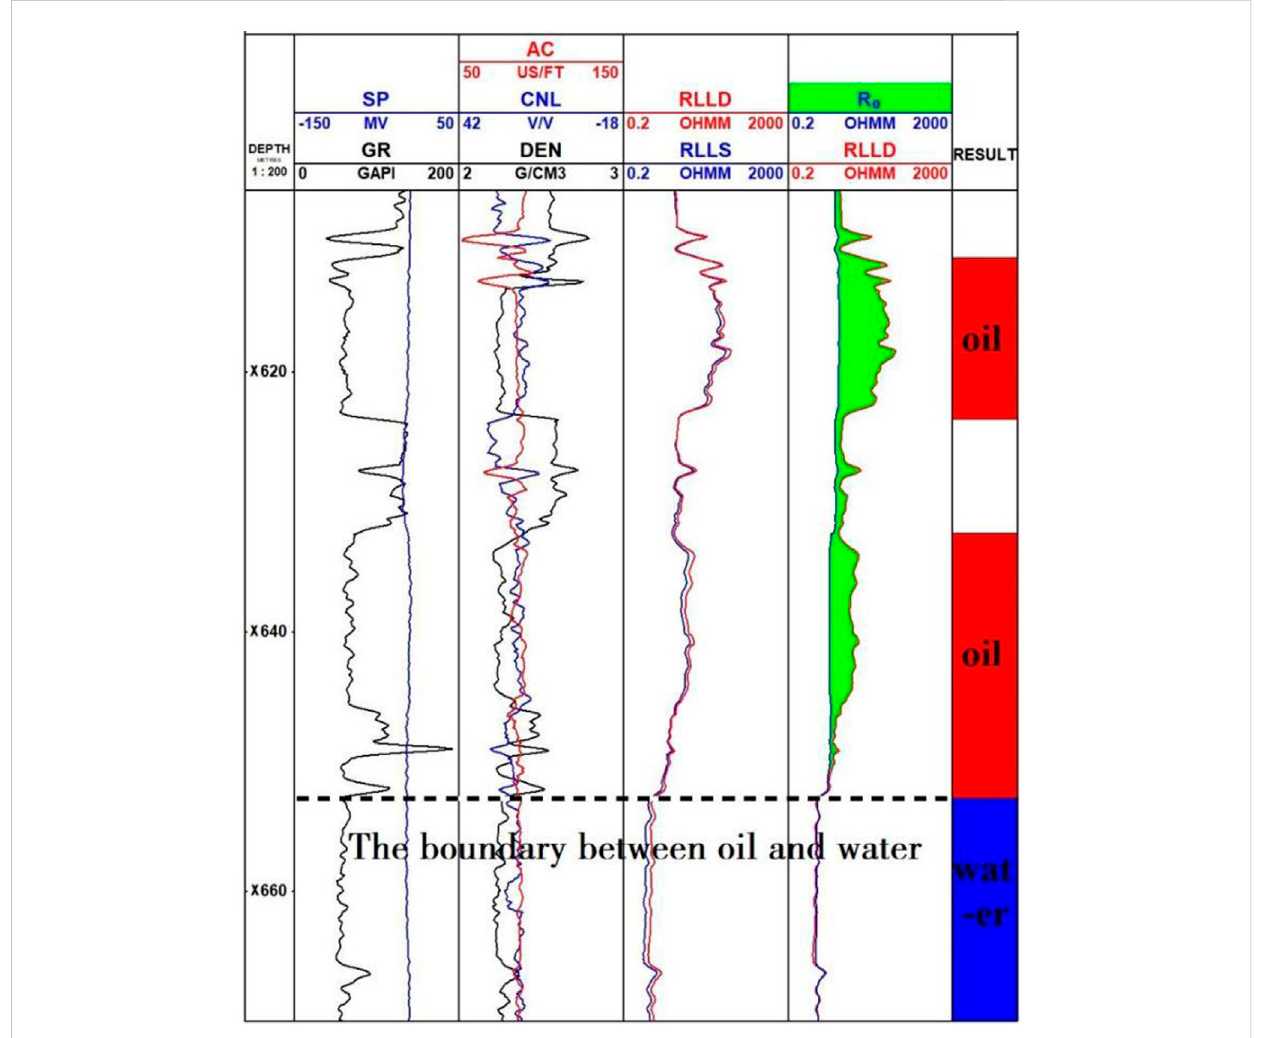
FIGURE 4 Result fi gure of R 0 predicted by the arti fi cial neural